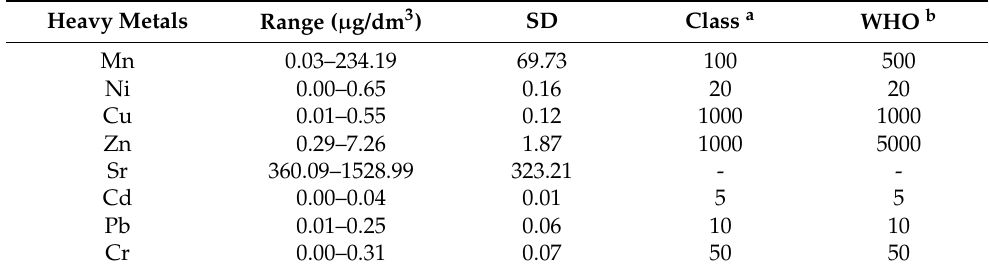
Table 3. Statistical analysis of heavy metal content in shallow groundwater in coal–poultry farming